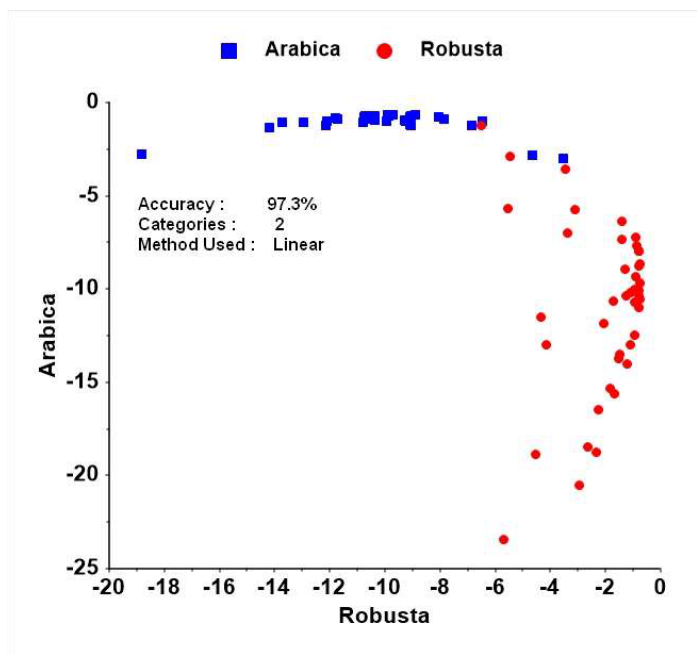
Figure 2. Discrimination among coffee species by linear discriminant analysis (LDA) using caffeine and chlorogenic acid derived from UV-Vis as predictor variables.